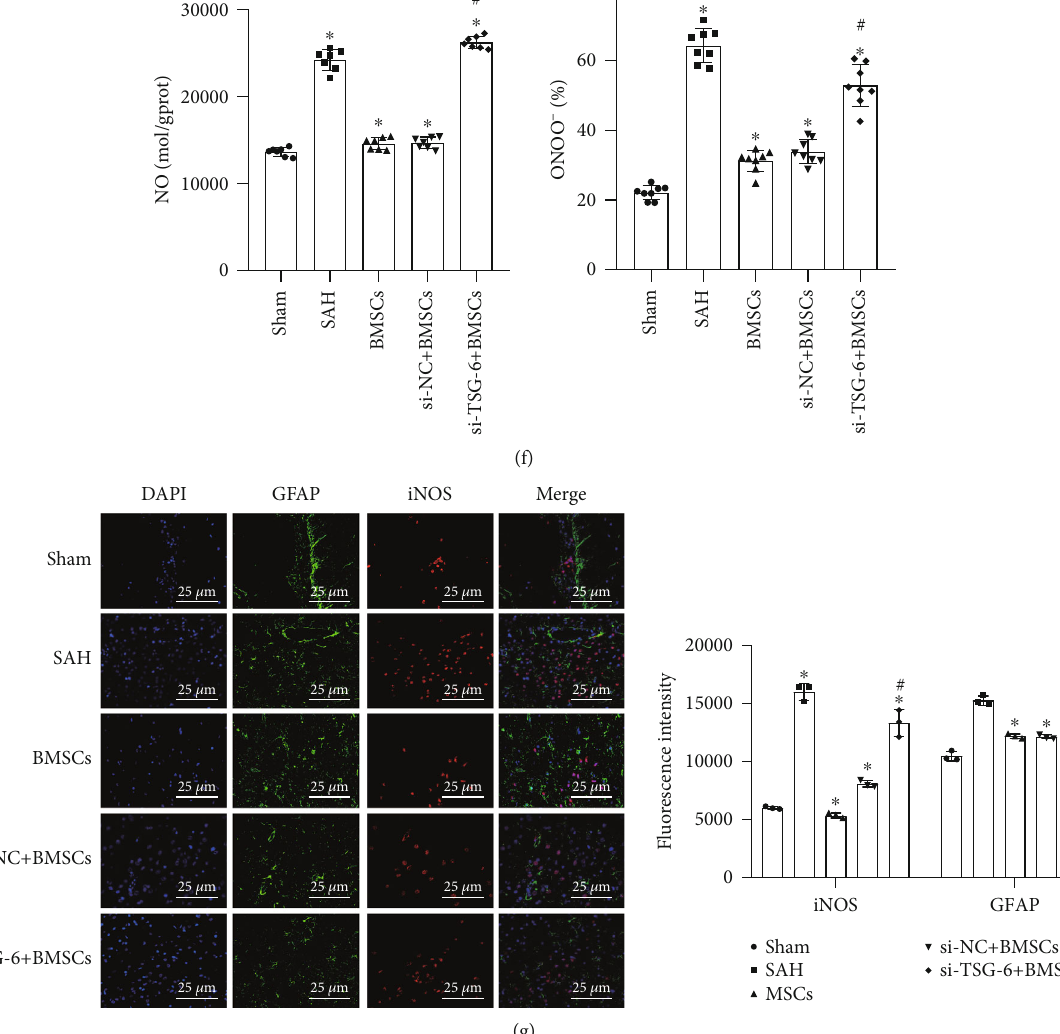
Figure 6: BMSCs regulate astrocytes through TSG-6 to treat rats su ff ering from SAH. (a) The expression of TSG-6 and iNOS was measured by qRT-PCR and Western blot. (b) qRT-PCR and Western blot were used to measure the expression level of the NF- κ B/MAPK signaling pathway. (c) ELISA was used to test the level of in fl ammatory factors secreted by activated astrocytes. (d) Evans blue detected changes in BBB permeability. (e) NO fl uorescent probe analyzed the amount of NO production in the cell. (f) Determination of the ONOO - level in rat serum by ELISA. (g) Double immuno fl uorescence staining was used to measure the expression of iNOS (red) and GAFP (green). BMSCs (medium containing BMSCs (TNF- α activation group)), si − NC + BMSCs (medium containing BMSCs (NC siRNA + TNF − α activation group)), and si − TSG − 6 + BMSCs (medium containing BMSCs ( siRNA − TSG − 6 + TNF − α activation group)). ∗ Compared with the sham group, P < 0 : 05 ; # compared with the si − NC + BMSC group, P < 0 : 05 . The above experimental results were all measurement data. Data are expressed as the mean ± SD . One-way ANOVA and Tukey ’ s test were used for the data comparison between multiple